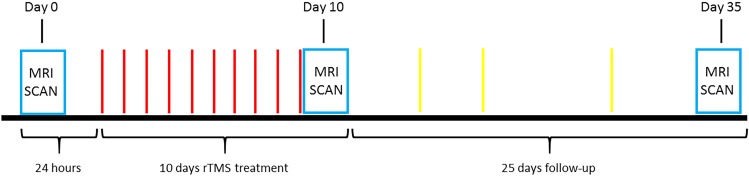
The paradigm of the entire experiment. On Day 0, each smoker participated in an MRI scan session to collect the structural imagine, resting state fMRI, and ASL data. With a 24-h abstinence from smoking after the first MRI scan the 10 days treatment began. A 20 Hz rTMS was applied on the left dorso-lateral prefrontal cortex and the superior medial prefrontal cortex, sequentially. At each daily rTMS treatment session, each site received 1000 pulses with a magnitude adjusted to 90% of the resting motor threshold. The CO level, withdrawal, and craving scales were collected every day. After the last treatment (Day 10), the smokers had the MRI taken that was same as Day 0. In the following 25 days the CO level, withdrawal, and craving scales were collected randomly. Again, at the end of F25 (Day 35), the MRI data were collected.